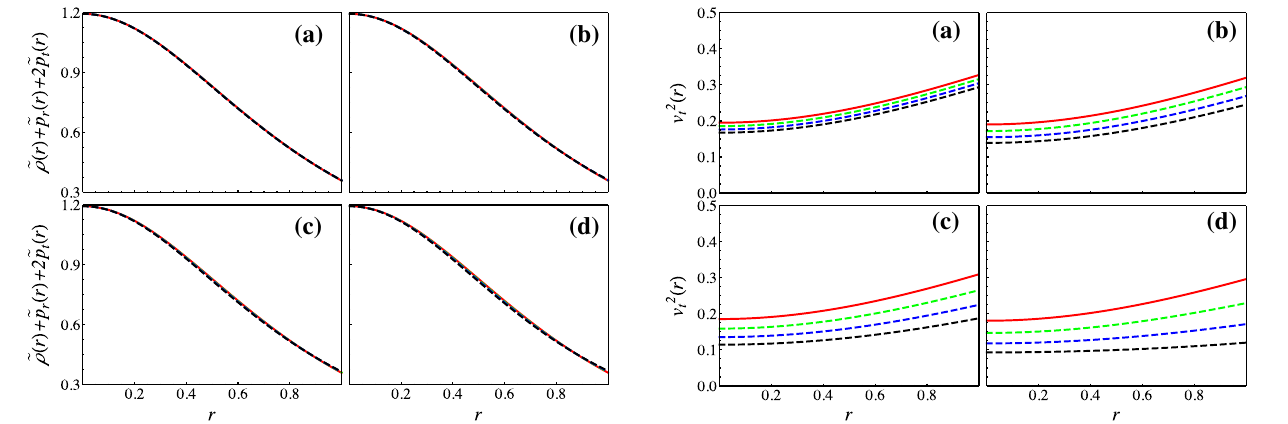
Fig. 6 SEC for M = 0 . 2, R = 1, c 1 = 0 . 5 and a C = − 0 . 1, b C = − 0 . 2, c C = − 0 . 3, d C = − 0 . 4. α = 0 . 1 (red line), α = 0 . 3, (green line), α = 0 . 5 (blue line), α = 0 . 7 (black line)